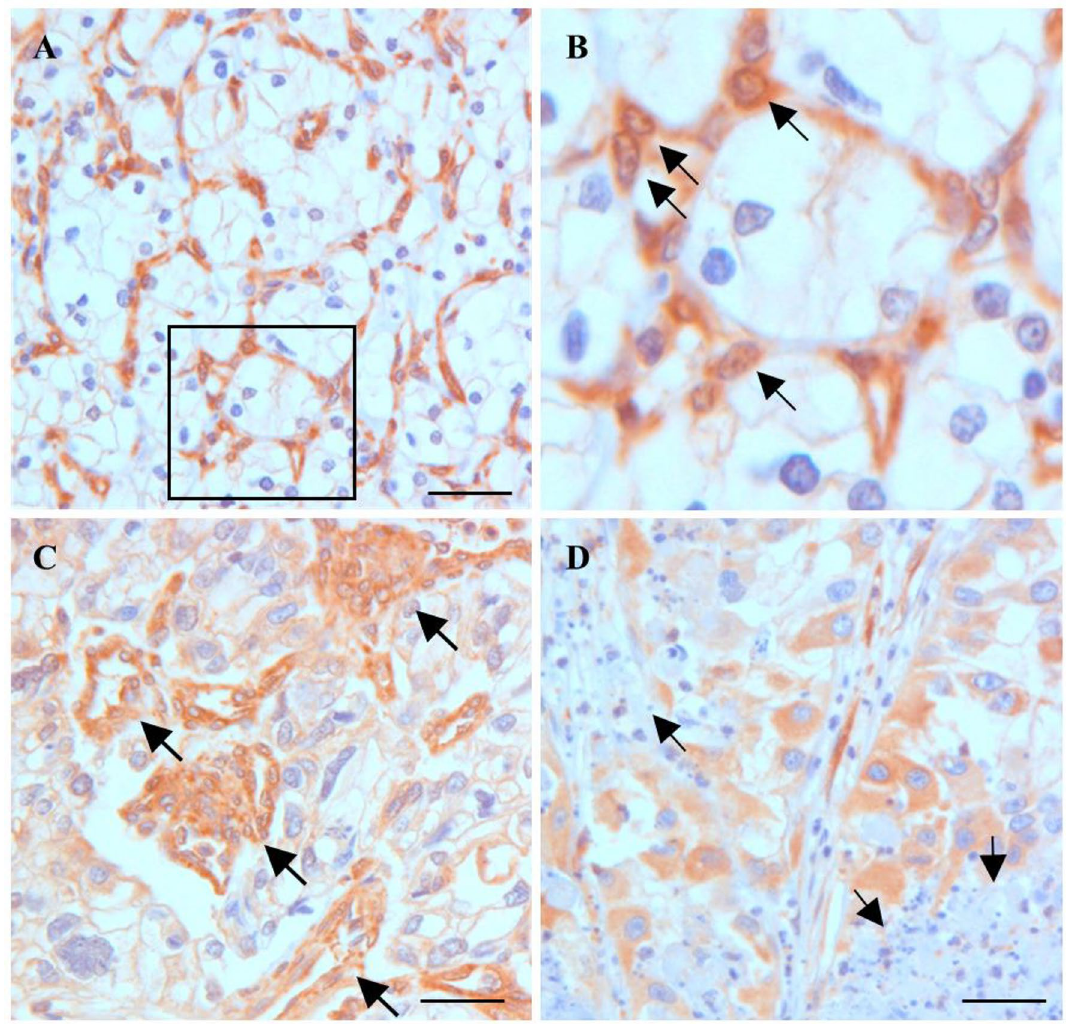
Figure 2. Expression of TXNIP in conventional RCC. ( A ) Strong TXNIP staining in endothelial cells but lack of expression in tumour cells. ( B ) Enlargement of the insert from A shows TXNIP translocation into endothel cell nuclei (arrows). ( C ) Irregular tortously growing TXNIP positive vessels in a grade 3 conventional RCC (arrows). ( D ) Small necrotic tumour areas are surrounded by tumour cells showing high expression of TXNIP protein (arrows). Scale bar: 40